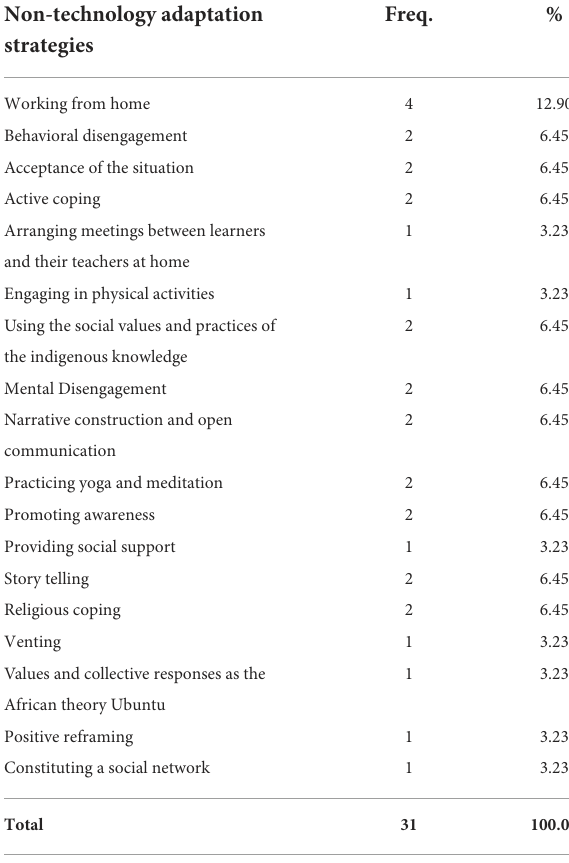
TABLE 9 Non-technology adaptation strategies during and after